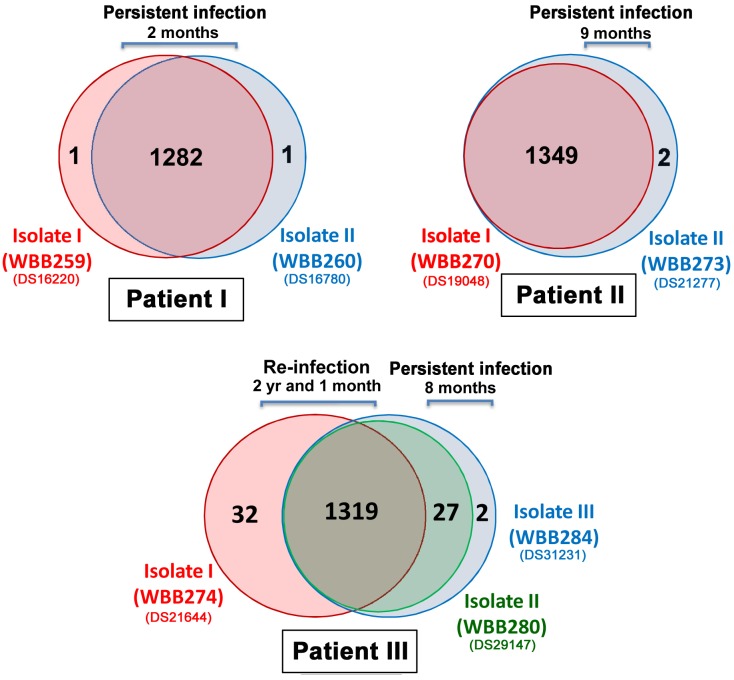
Venn diagram comparing the number of SNPs shared by serially isolated M. tuberculosis isolates.